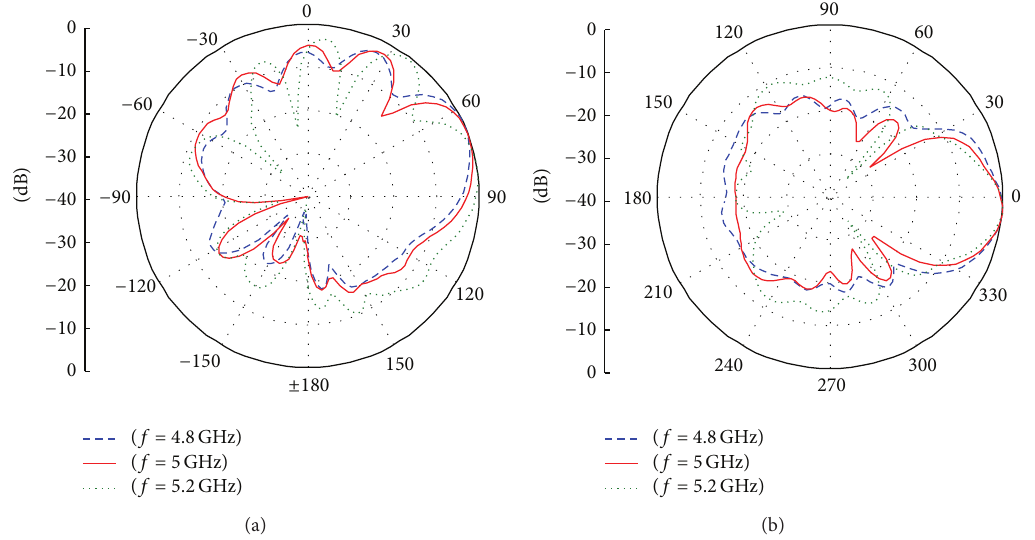
Figure 8: Measured radiation patterns in the elevation (a) plane and in the azimuth (b) plane for the 12-element Yagi array (Figure 7).